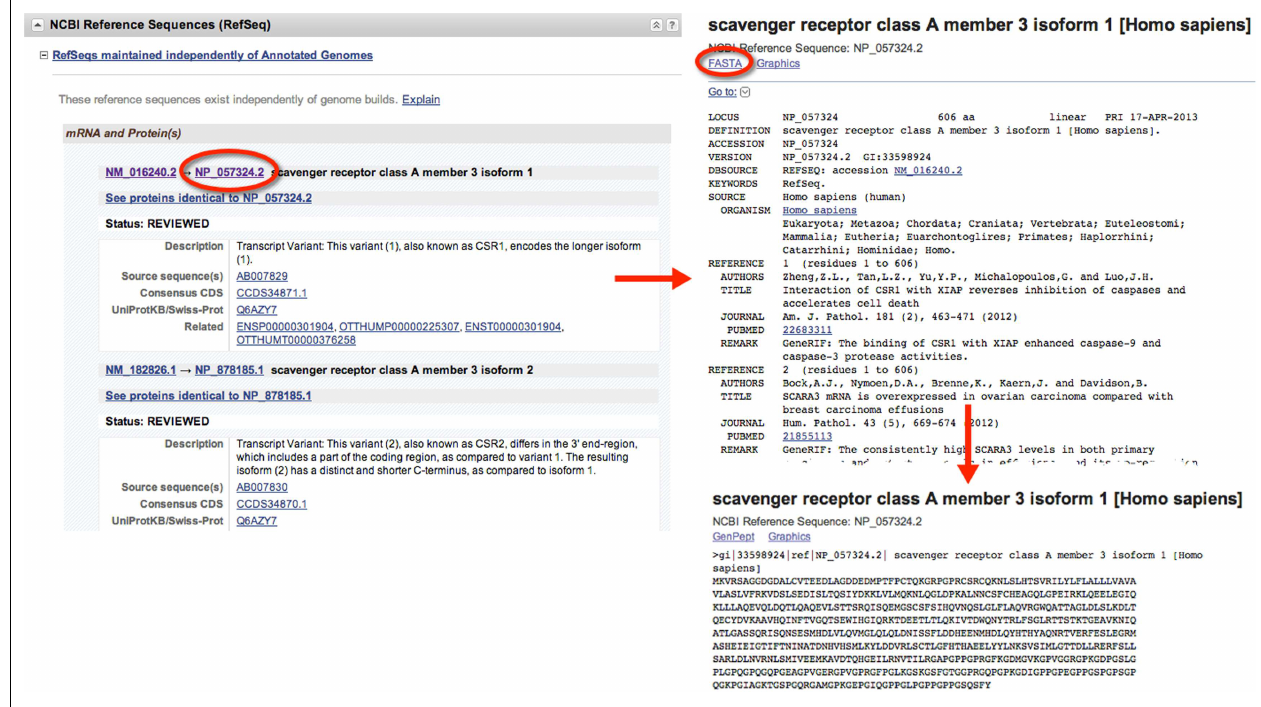
FIGURE 1 | Retrieval of nucleic acid and protein FASTA formatted sequences from an Entrez Gene search . Upon searching for and selecting the Homo sapiens SCARA3 gene, a variety of information can be retrieved including identifiers for the Ensembl, Mendelian Inheritance of Man (MIM), and Human Protein Reference Database, in addition to information about the genomic context of the gene. From the “ NCBI Reference Sequences (RefSeq) ” section, the most up-to-date and thoroughly curated FASTA formatted sequences may be obtained. Sequences with Accession